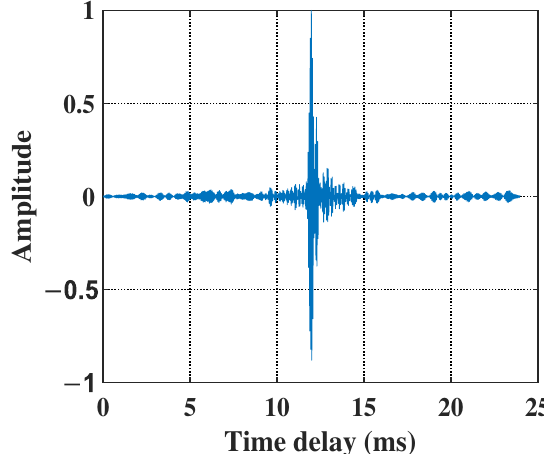
Figure 15. The CIR of the lake experiment